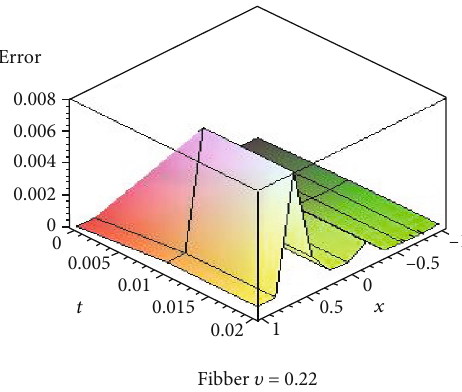
Figure 6: The value absolute error by TMM at N = 10 and T = 0 : 2 for ∣ x ∣ <1 , i.e.,